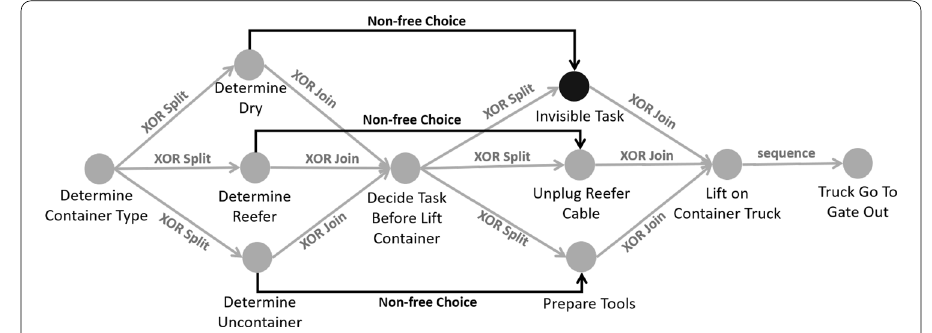
Fig. 1 A process model of port container